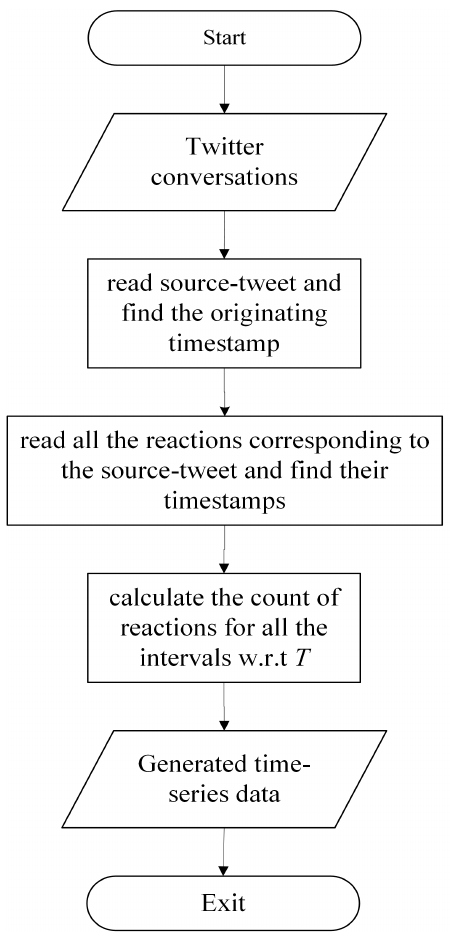
Figure 4. The flow chart for transforming Twitter conversations into time-series